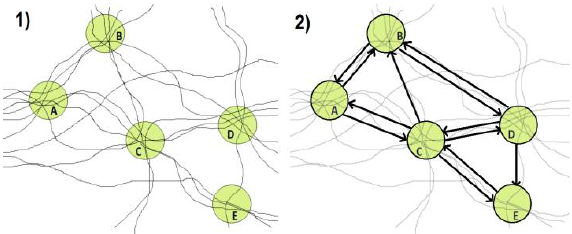
Figure 1: Using a places extraction algorithm for creating the graph as basis for the prediction algorithm